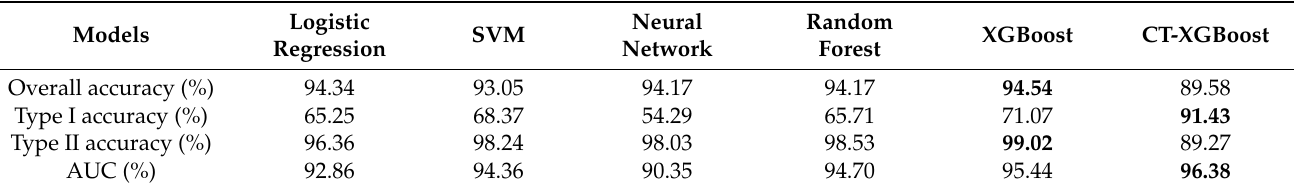
Table 1. Credit default prediction performance comparison analysis of different prediction